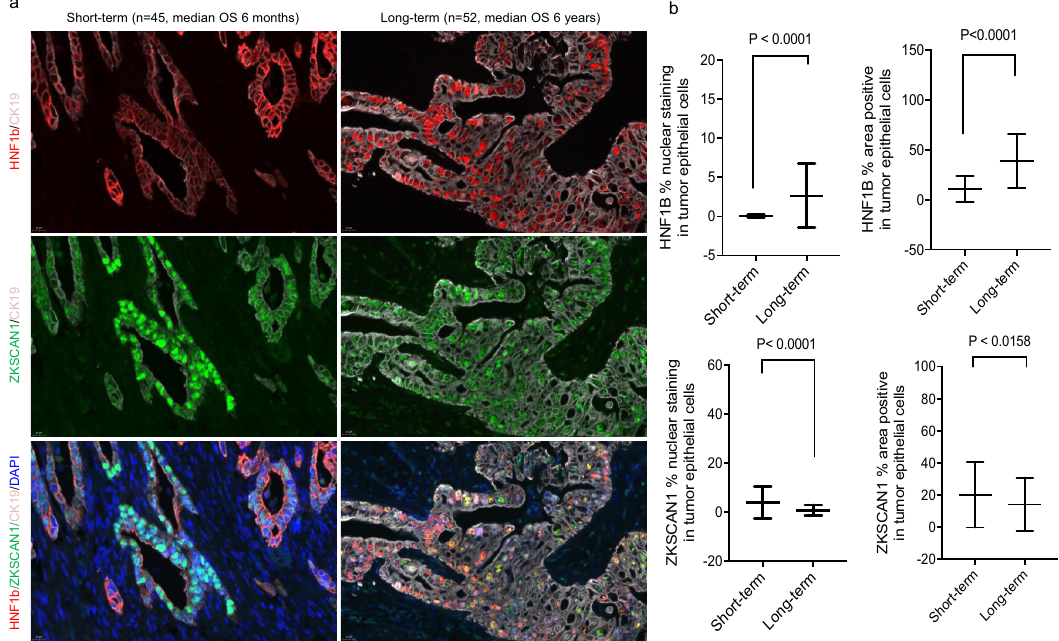
Fig. 2 Validation of nuclear localization of HNF1b and ZKSCAN1 on tissue microarray from an independent PDAC cohort ( n = 97) selected for long- and short-term survival. a Staining of HNF1b (red) (upper panel), ZKSCAN1 (green) (middle panel), and combined signal of these two TFs with DAPI (blue) and CK19 (gray) (lower panel), in short-term and long-term survivors. Scale bars are 20 μ M as displayed at the left bottom corners of all the micrographs. b Quantitation of cells displaying nuclear staining as well as total staining (area positive) for HNF1b (upper panel), and ZKSCAN1(lower panel). Data represented as mean + SD. Statistical tests are unpaired two tailed t-test with P < 0.05 is signi fi cant, comparing short-term ( n = 45) and long-term ( n = 52) survivor patients (Source data are provided as a Source Data fi